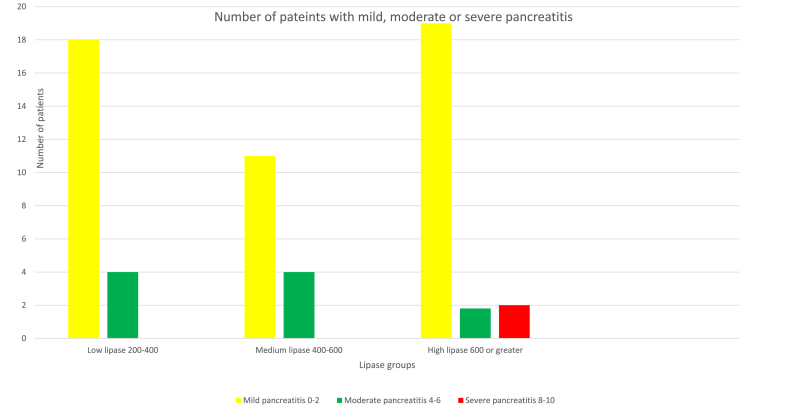
Number of patients with mild, moderate or severe pancreatitis based on MCTSI scores and subdivided into low, medium, or high lipase lab values.